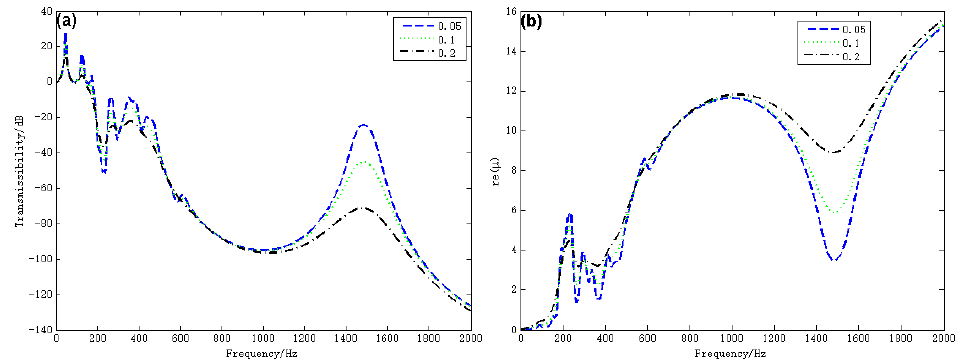
Figure 12. Band gap behavior of the reverse designed struts with different damping. ( a ) Transmission capability of the finite strut. ( b ) Attenuation constant of corresponding supercell.